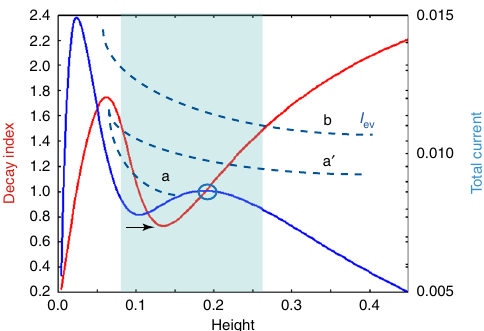
Fig. 9 Decay index and total current fl owing inside of the fl ux tube, plotted as a function of height. Red and blue lines show the decay index and total current of the fl ux tube taking the equilibrium as a function of height. These are measured along the dotted line shown in Fig. 3d, i.e., the decay index corresponds to Fig. 3g. Solid black arrow indicates the local minimum value of the decay index and blue circle points out the local maximum of the total current. A region highlighted by blue square corresponds to one satisfying n ≤ 1.5. Dashed blue lines (a, b and a ′ ) are assumed as evolutions of the dynamic current I